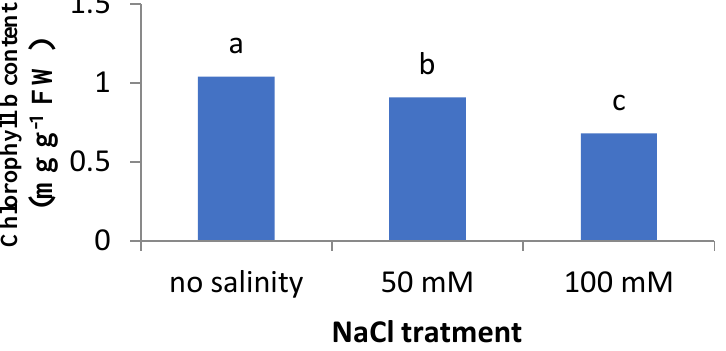
Figure 4. Effects of salinity (mM of NaCl) on chlorophyll b content of Aloe vera . Different letters on bars indicate significant differences at p < 0.05 by LSD test.